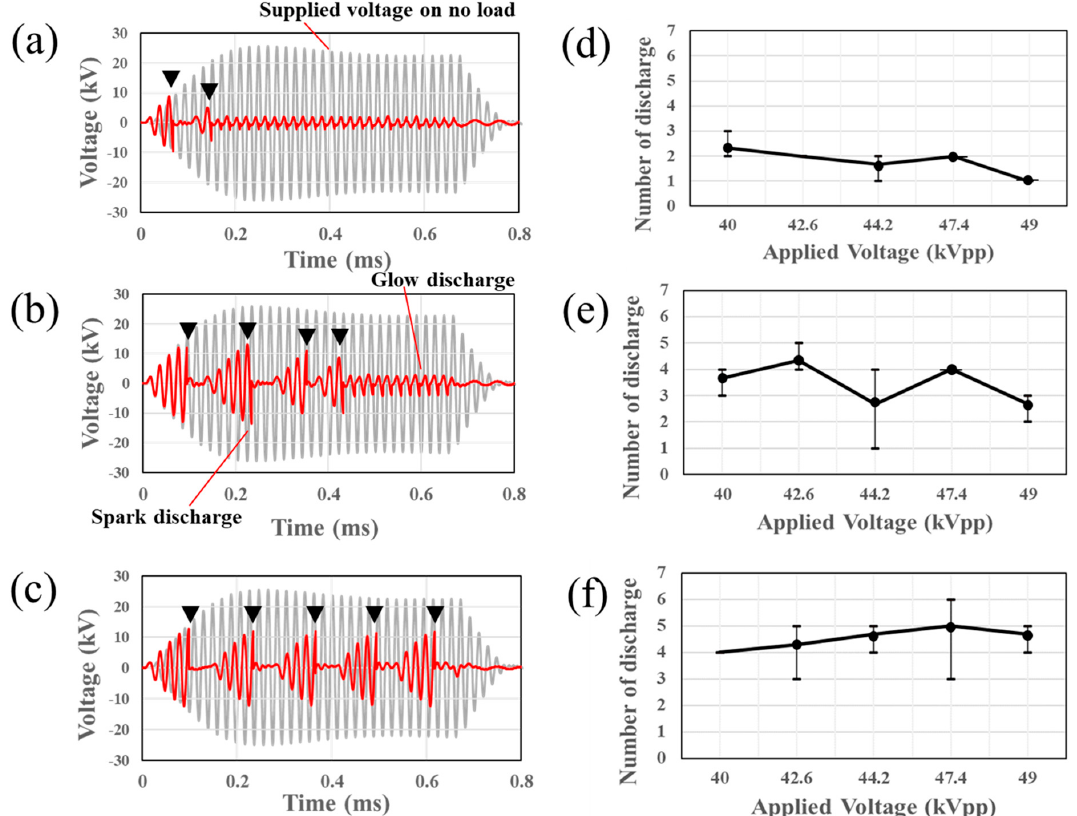
Figure 7. Observed voltage waveform and discharge number. The applied voltage waveform without a load connection was plotted in solid black lines, while voltage waveforms with electrode connections were plotted in solid red lines. ( a ) Voltage waveform at 5 mm gap without airflow. ( b ) Voltage waveform at 10 mm gap without airflow. ( c ) Voltage waveform at 10 mm gap with airflow. A voltage drop appeared on the waveforms, and current levels increased suddenly. This is called the spark discharge and is counted in 1 ms time units. ( d ) Graph showing number of discharges at 5 mm gap without airflow. ( e ) Graph showing number of discharges at 10 mm gap without airflow. ( f ) Graph showing number of discharges at 10 mm gap with